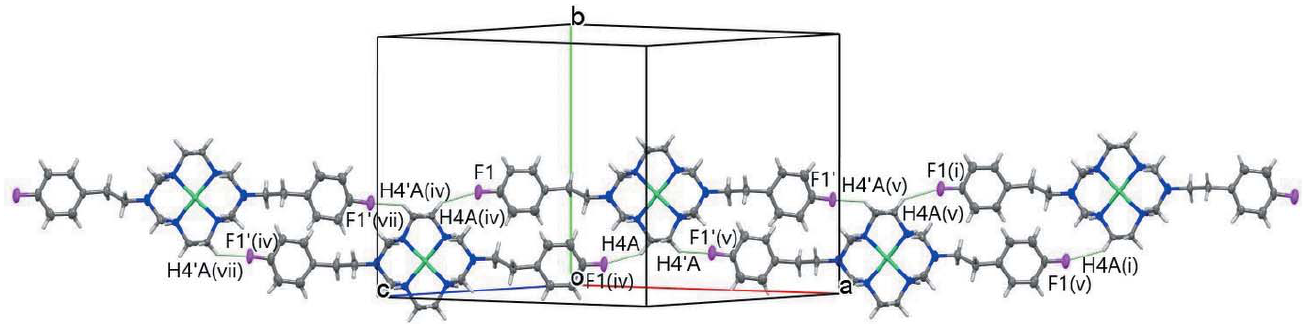
Figure 3 Aview showing the one-dimensional chain propagation of rings formed by the intermolecular hydrogen bonding between F1 (cid:3)(cid:3)(cid:3) H4 A and F1 0 (cid:3)(cid:3)(cid:3) H4 0 A in [Ni L ] 2+ . Symmetry codes: (i) 1 (cid:5) x , y , 1 [Ni L ] 2+ components is shown.